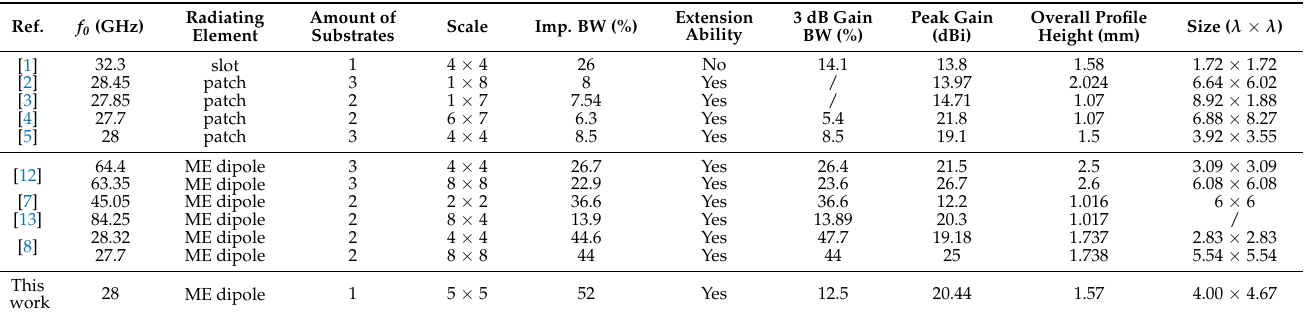
Table 2. Comparison of the proposed 5 × 5 interconnected ME dipole antenna array with related published